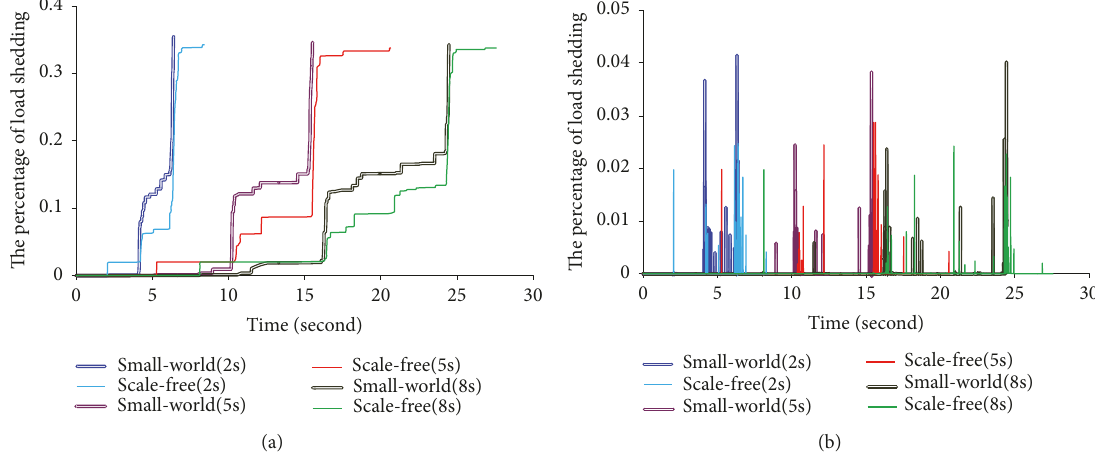
Figure 6: Load shedding of IEEE 118-bus system over time with low-degree initial infectious vertexes. (a) Total load shedding over time; (b) real-time load